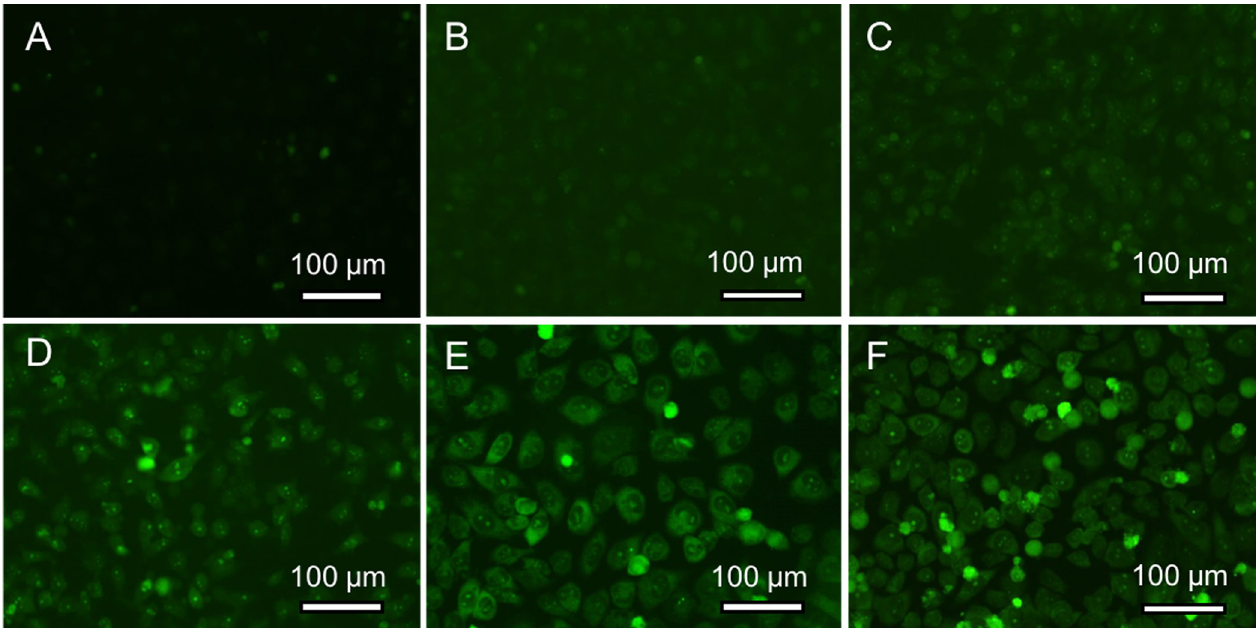
Fig 3. The fluorescent images of HeLa cells incubated with 400 μ g/mL of carbon dots from CA: EDA 1:2 for 0 h (A), 1 h (B), 2 h (C), 4 h (D), 8 h (E) and 24 h (F), respectively (under blue